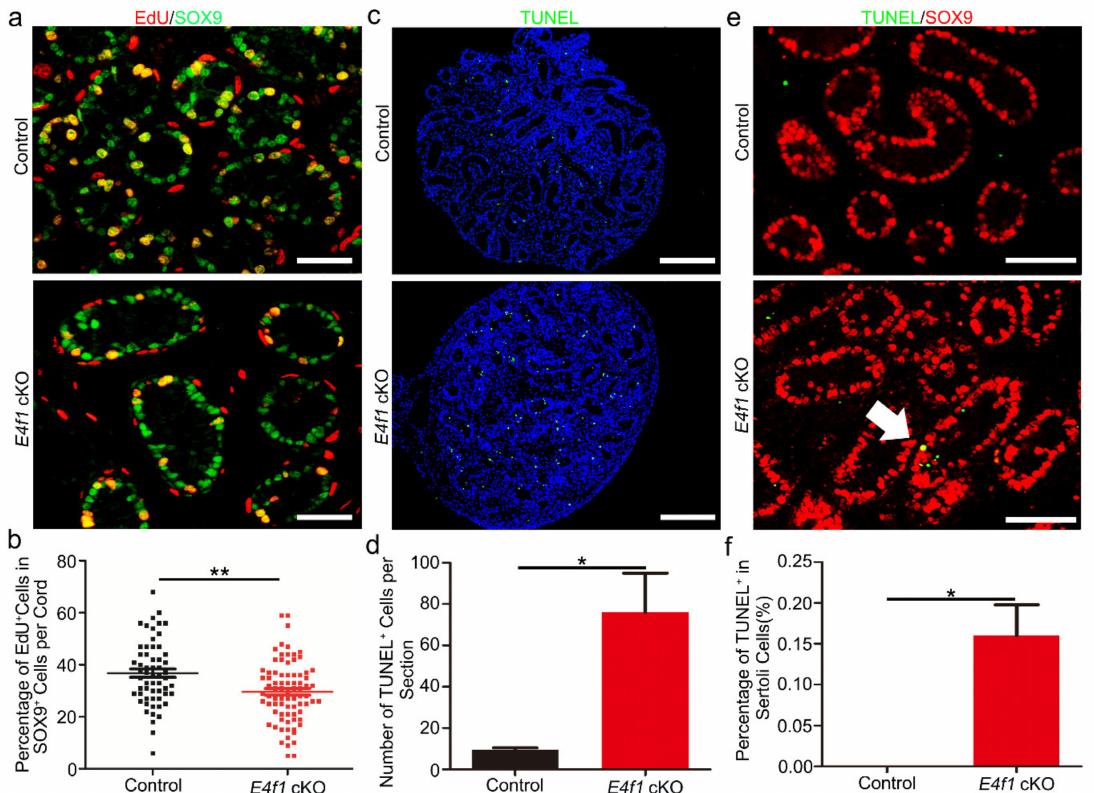
Figure 5. E4f1 deletion a ff ected proliferation and apoptosis in Sertoli cells. ( a ) Immunofluorescence staining of EdU and SOX9 in cross-sections of testes from control and E4f1 cKO males at PD0. Scale bar = 50 µ m. ( b ) Percentages of proliferative Serotli cells in cross-sections of testes from control and E4f1 cKO males at PD0. n = 3. ( c ) TUNEL staining in cross-sections of testes from control and E4f1 cKO males at PD0. Scale bar = 50 µ m. ( d ) Quantification of TUNEL + cells in control and E4f1 cKO males. n = 3. ( e ) Immunofluorescence co-staining of TUNEL and SOX9 in cross-sections of testes from control and E4f1 cKO males at PD0. Scale bar = 50 µ m. ( f ) Quantification of apoptotic Sertoli cells in testes from PD0 controls and E4f1 cKO male mice. n = 3. * and ** denotes significantly di ff erent at p < 0.05 and p <